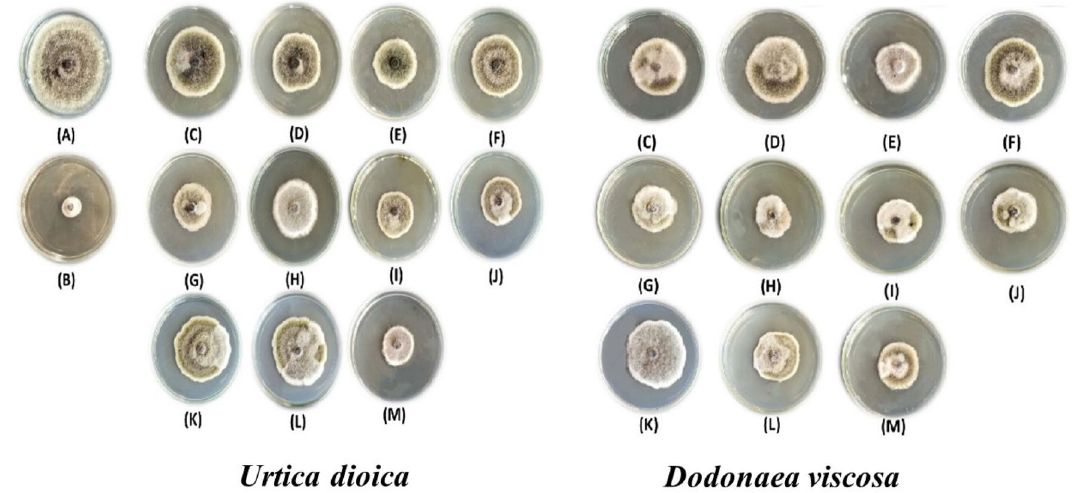
Figure 7. Antifungal activity of Urtica dioica and Dodonaea viscosa most abundant compounds and mixtures. A = Control, B = Positive control (Ridomil), C = Caffeic acid, D = Ferulic acid, E = α-Tocopherol, F = Ferulic acid + caffeic acid, G = Ferulic acid + coumaric acid, H = Ferulic acid + α-tocopherol, I = Caffeic acid + coumaric acid, J = Caffeic acid + α-tocopherol, K = Coumaric acid + α-tocopherol, L = Coumaric acid, M = Total